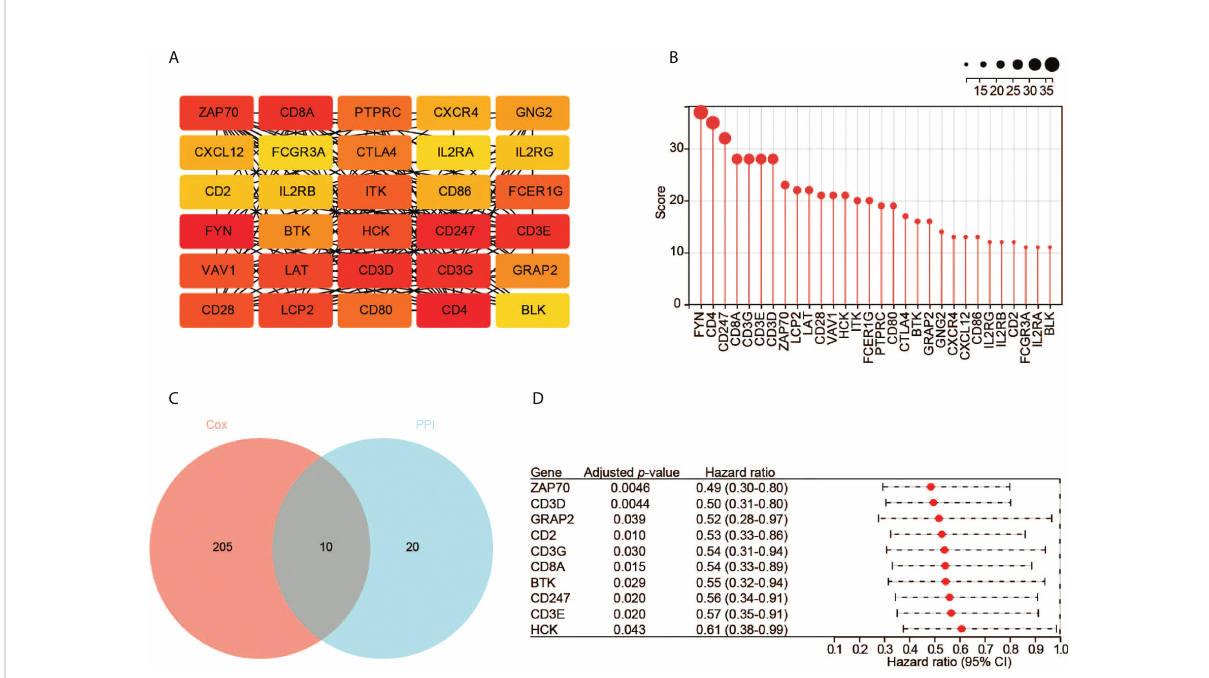
FIGURE 4 Identi fi cation of hub genes. (A) The top 30 hub genes based on the analysis of PPI network. Color from yellow to red represents the low to high MNC score. (B) The MNC scores of the top 30 hub genes. (C) The 10 key genes based on the interaction of the two datasets. (D) The survival analysis with the univariate Cox regression model. Here shows the 10 key